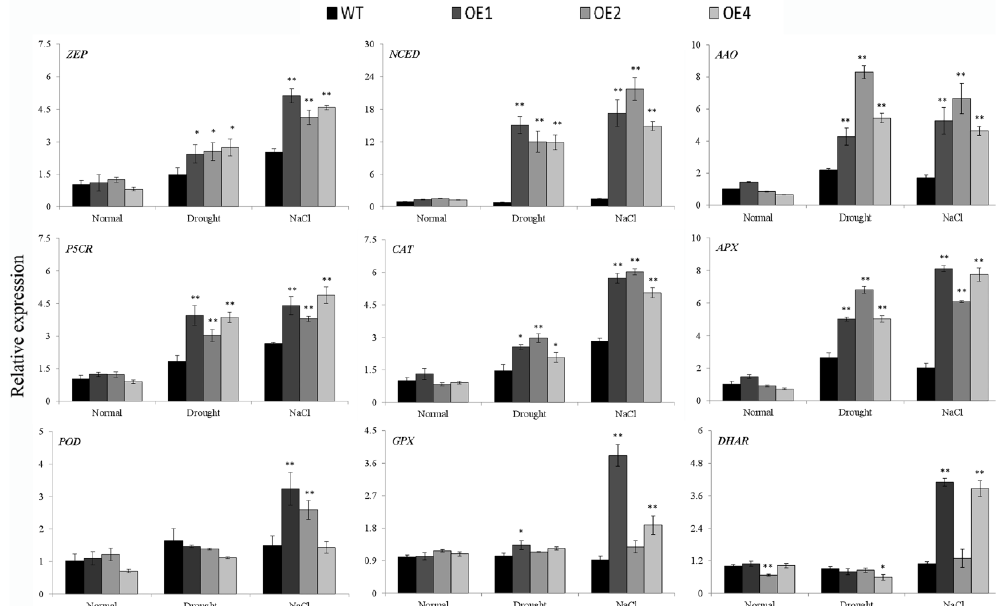
Figure 9. Transcript levels of drought- and salt-responsive genes in transgenic Arabidopsis and WT plants. The plants were grown under normal conditions for two weeks and then used for normal, NaCl, and drought stress treatments. After one week of treatment, the leaves of transgenic lines and WT were sampled for analysis. Data are presented as means ± SE (n = 3); * and ** indicate a significant di ff erence at p < 0.05 and p < 0.01, respectively. The gene expression in WT under normal conditions was set to 1, and the expression in the other samples was adjusted